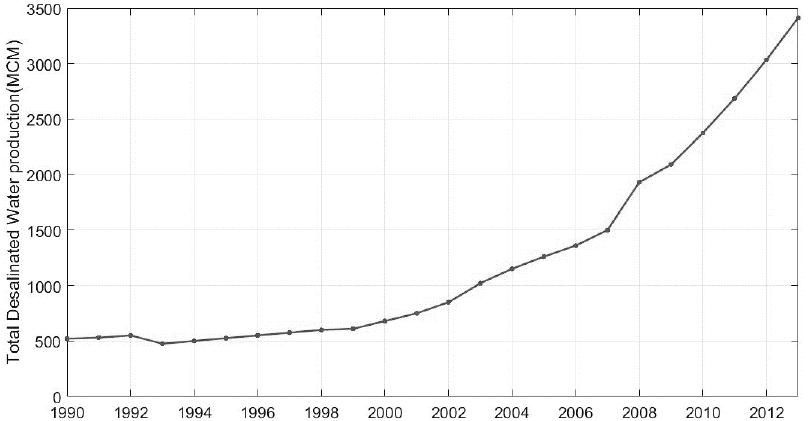
Figure 6. Total desalinated water production in the UAE from 1990 to 2012.